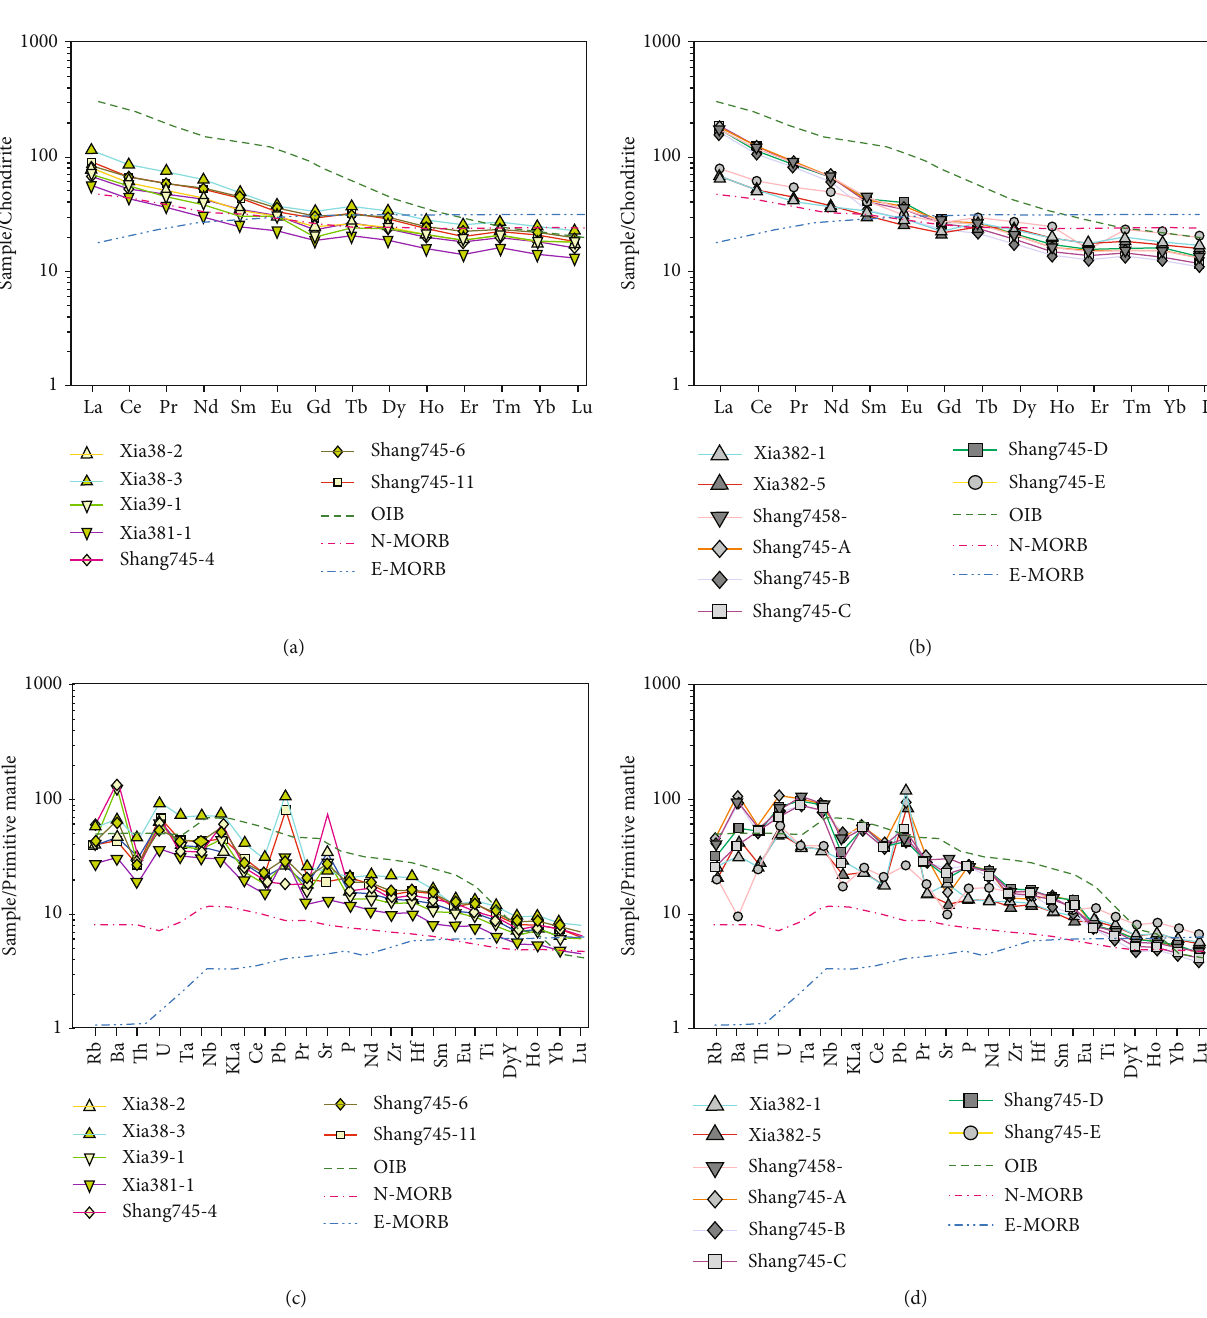
Figure 5: (a, b) Chondrite-normalized REE patterns and (c, d) primitive mantle (PM) normalized trace element diagrams for the Paleogene igneous rocks in Huimin Sag. The values of chondrite and PM are from Sun and McDonough